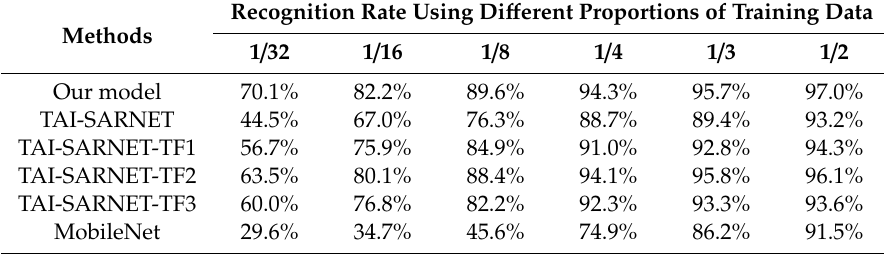
Table 5. Recognition results when using small sample sizes.